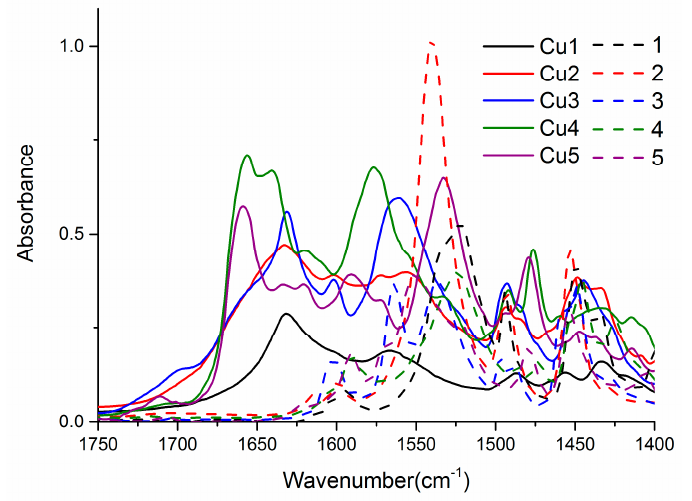
Figure 3. ATR-IR spectra of complexes and free ligands in the region 1750–1400 cm − 1 .